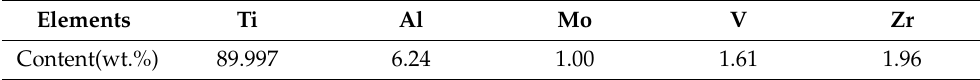
Table 1. The composition of TA15 powders. Elements Ti Al Mo V Zr